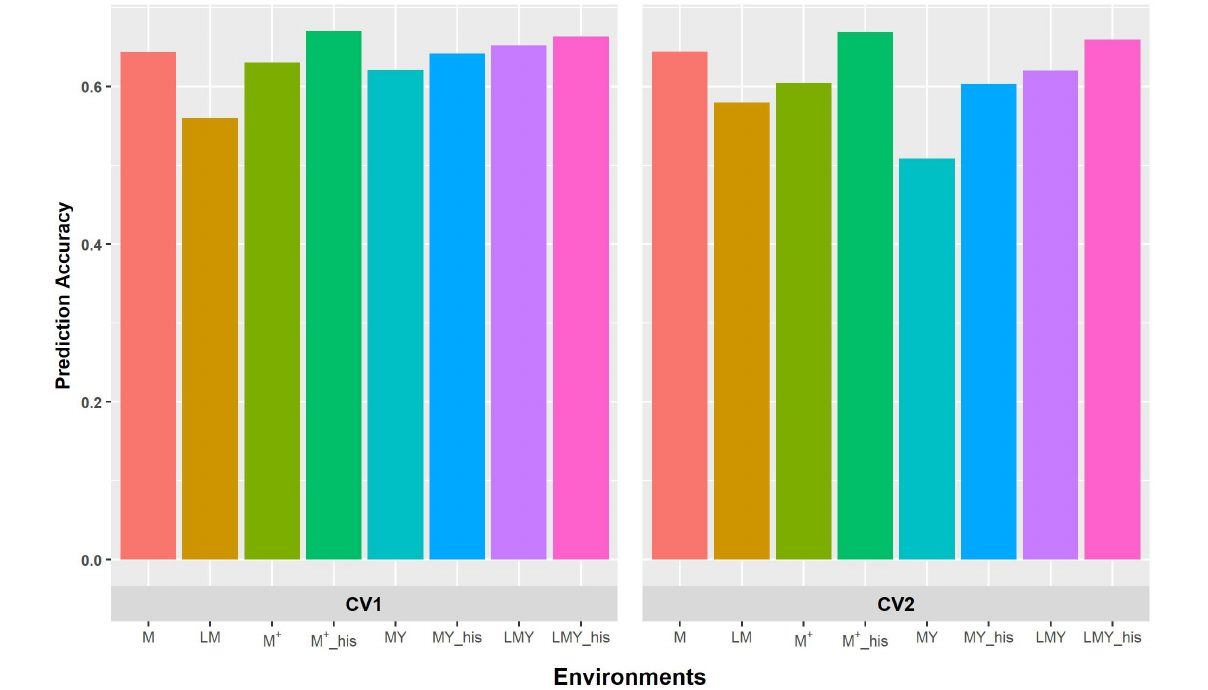
Frontiers in Plant Science |